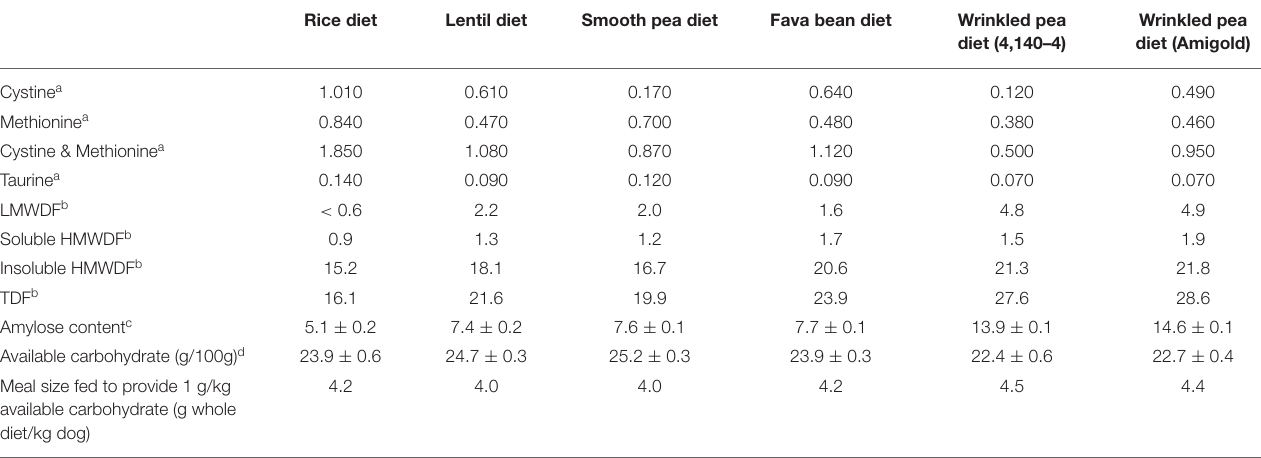
TABLE 3 | Cystine, methionine and taurine levels in test diets after extrusion and fat coating. Rice diet Lentil diet Smooth pea diet Fava bean diet Wrinkled pea